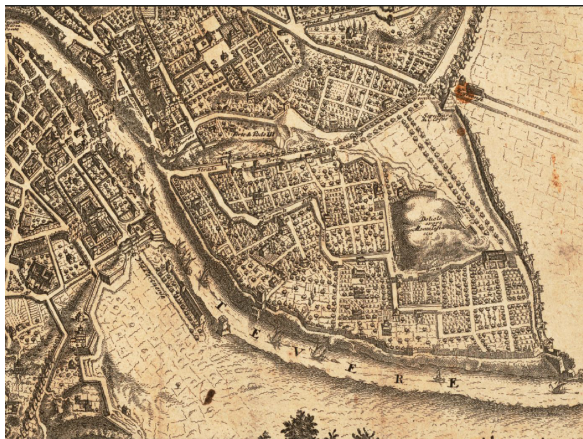
Figure 9. Novissima et acuratissima delineatio Romae veteris et novae, in viatorem usum et commoditatem of Giovanni Battista Falda, approx.